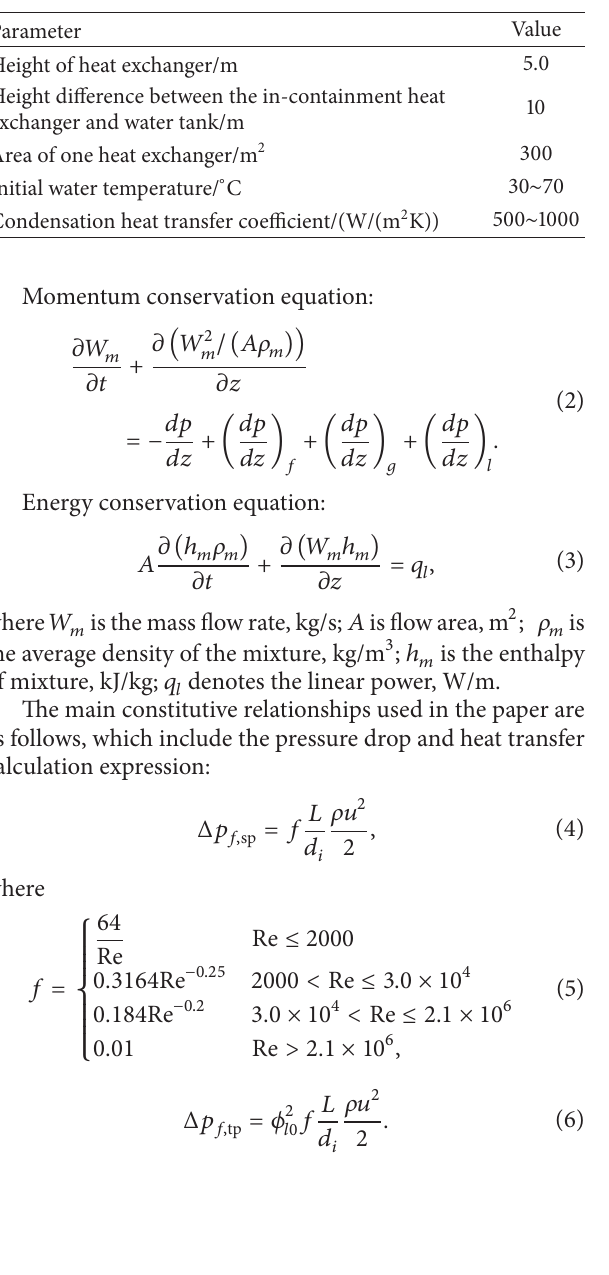
Table 1: Parameters of OLPCCS